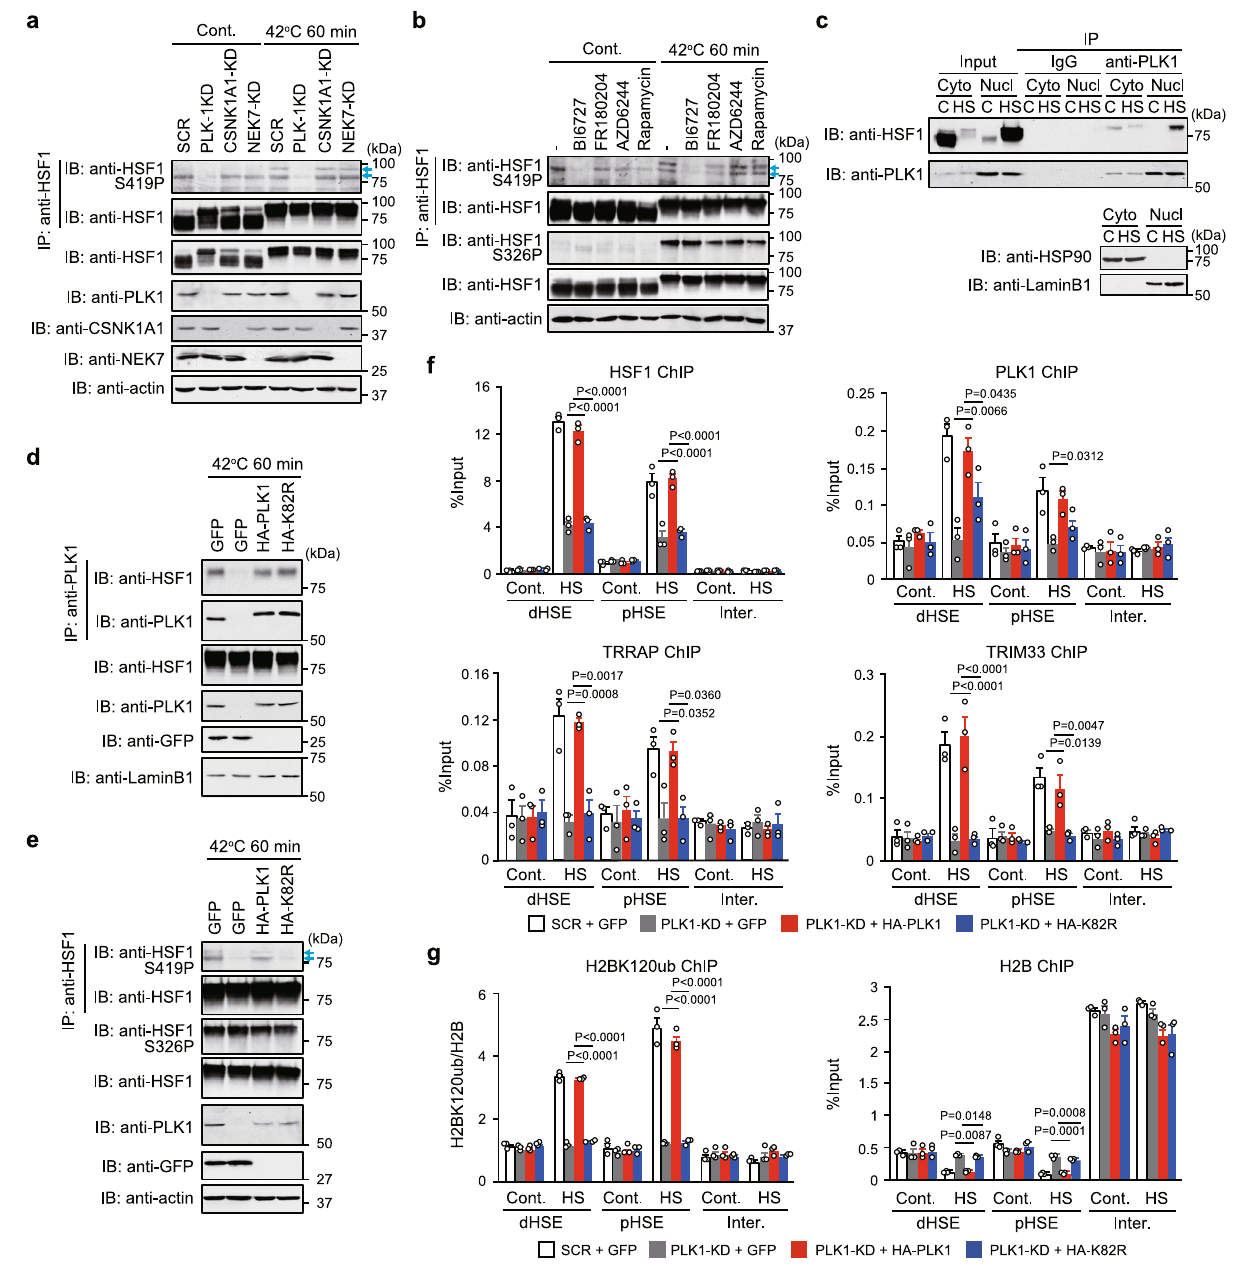
Fig. 5 | PLK1 phosphorylates HSF1-S419 and triggers histone modi fi cations. HeLa cells were infected with adenovirus expressing shRNA for PLK1, CSNK1A1, NEK7 or SCR ( a ), or treated with BI6727 (PLK1 inhibitor), FR180204 (ERK1/2 inhibitor),AZD6244(MEK1/2inhibitor),orrapamycin(mTORinhibitor)( b ).These cells were then treated with heat shock. Cell extracts were subjected to HSF1 immunoprecipitation and immunoblotting using antibody for HSF1 phospho- S419 or HSF1. Blue arrows indicate the positions of HSF1-S419 phosphorylated bands. The intensity of the upper band was markedly enhanced during heat shock. c PLK1 interacts with HSF1 in the nucleus during heat shock. Cell extracts were prepared as described in Fig. 1b and subjected to immunoblotting. Cells, in